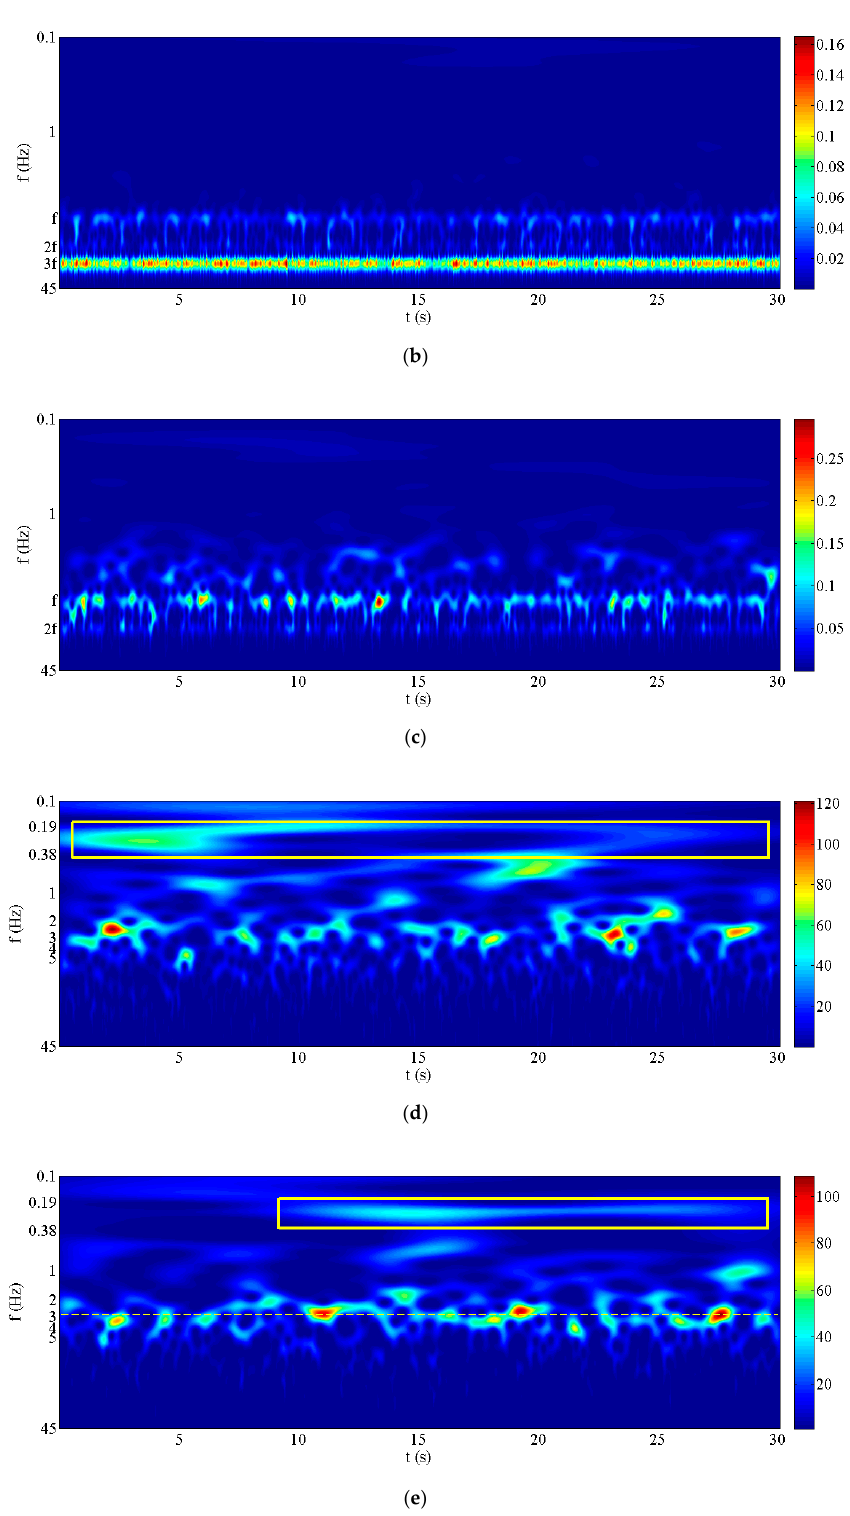
Figure 11. The wavelet spectrum of the time series signal of the streamwise fluctuating velocity at di ff erent positions of the turbine wake with configuration C, n = 3, c = 108 mm: ( a ) schematic diagram,